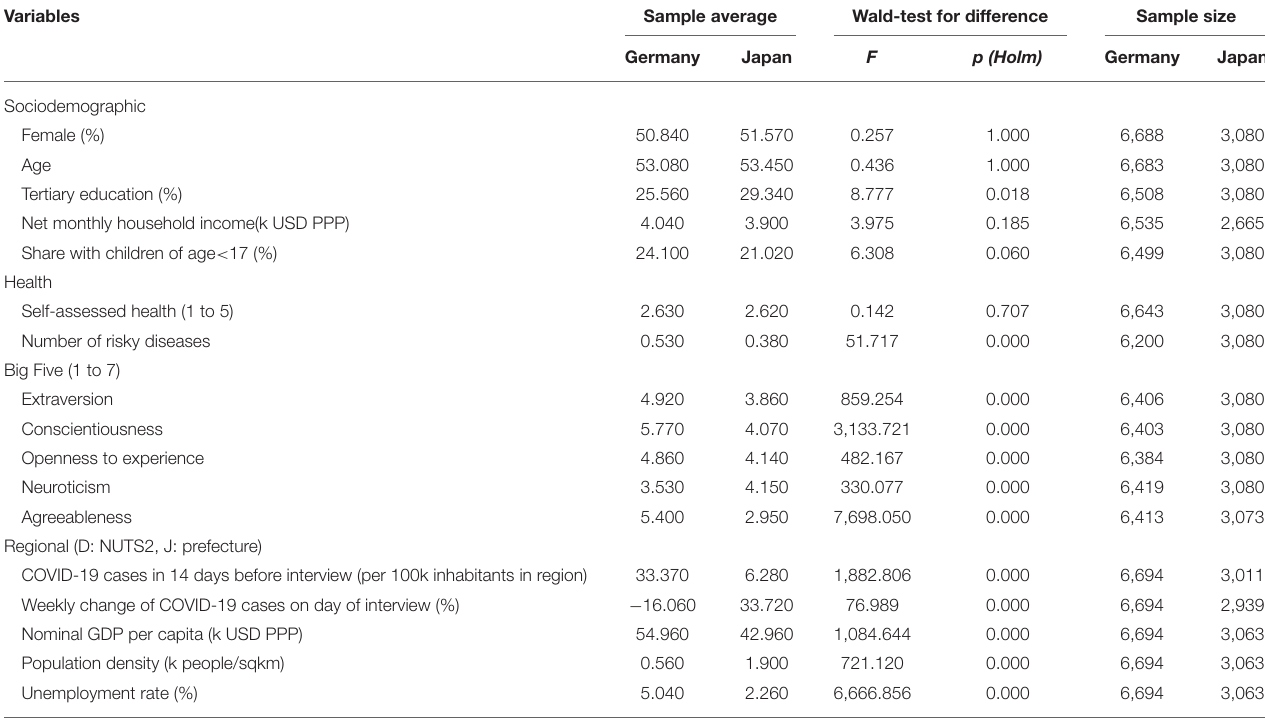
TABLE 2 | Covariates by